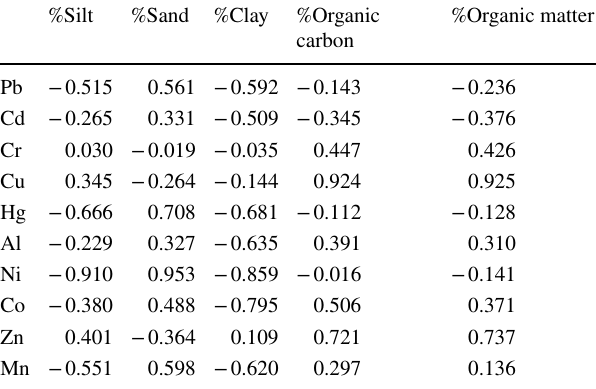
Table 6 Correlation matrix of heavy metals in sediment